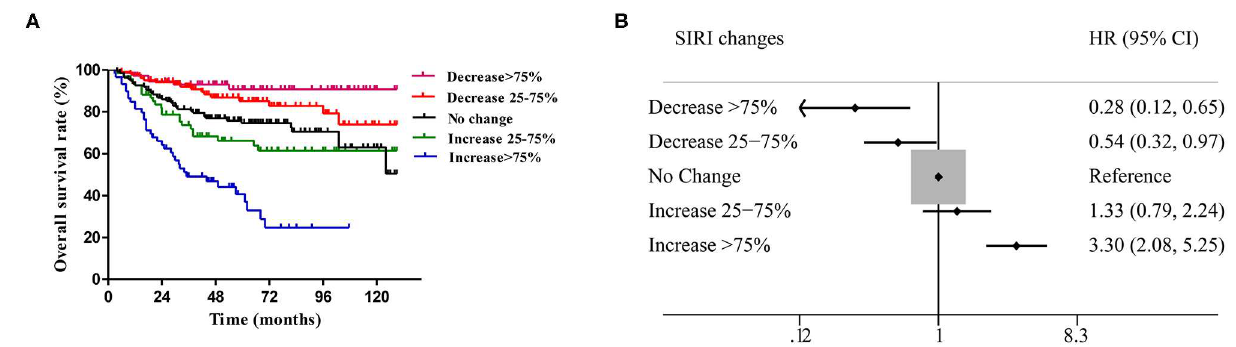
FIGURE 6 | (A) Different changes of SIRI before and after radical operation in cervical cancer have significant prognostic value. (B) Compared with those with unchanged SIRI (absolute value of variation < 25%), cervical cancer patients with an increase in SIRI > 75% had worse OS ( P < 0.001), while patients with a decrease in SIRI > 75% had a better prognosis ( P <